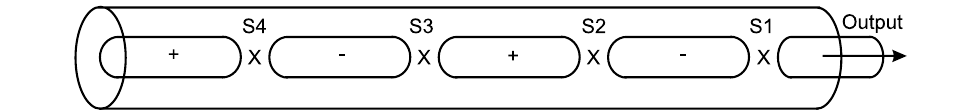
FIG. 10. Frozen wave generator concept for providing short bipolar pulse train. (All switches are closed simultaneously. Variants with sequentially closed switches may be useful.)